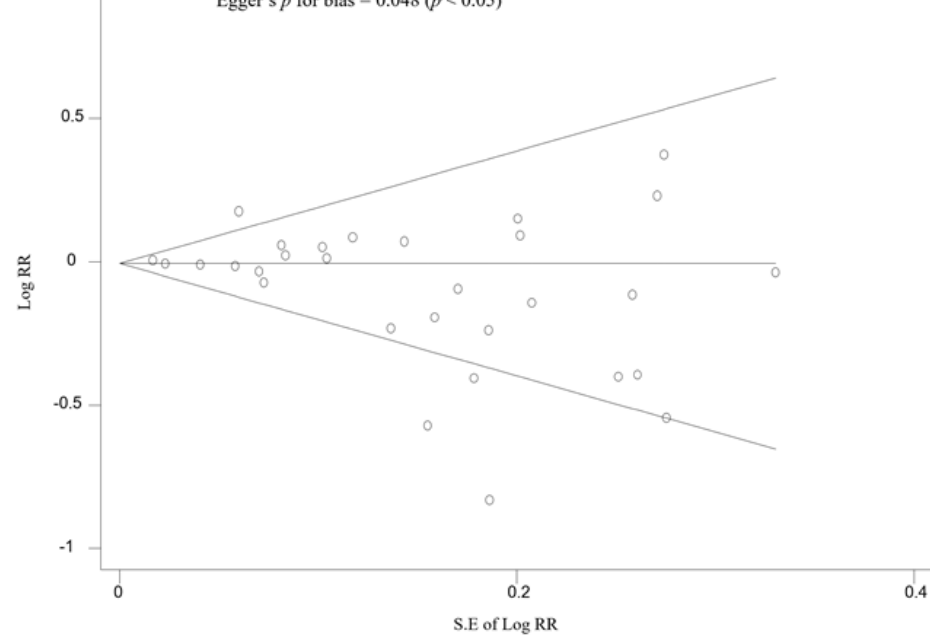
Figure 5. Begg’s funnel plot and Egger’s test for identifying publication bias of randomized con- trolled trials. RR, relative risk; S.E, standard error. trials. RR, relative risk; S.E, standard